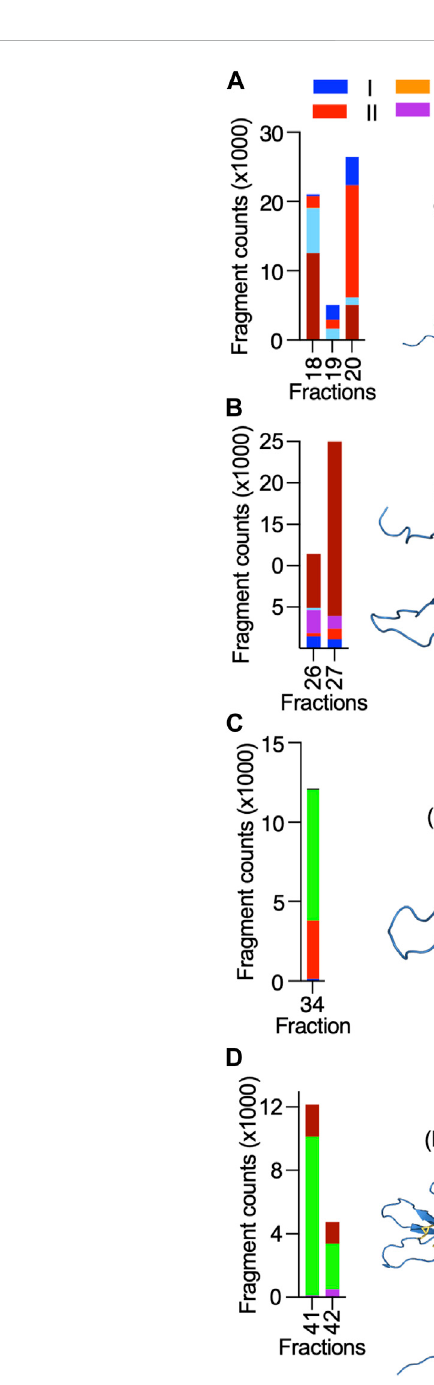
2 to fold into cystine-knot scaffolds typical of spider-venom peptides (King and Hardy, 2013) (Figure 4). Scaffolds II-VIII either form elaborated cystine-knot folds with extra disulphide bonds, or alternative structures such as for scaffolds III and IV (Figure 4). Novel peptides with high identity with other toxins and not previously described